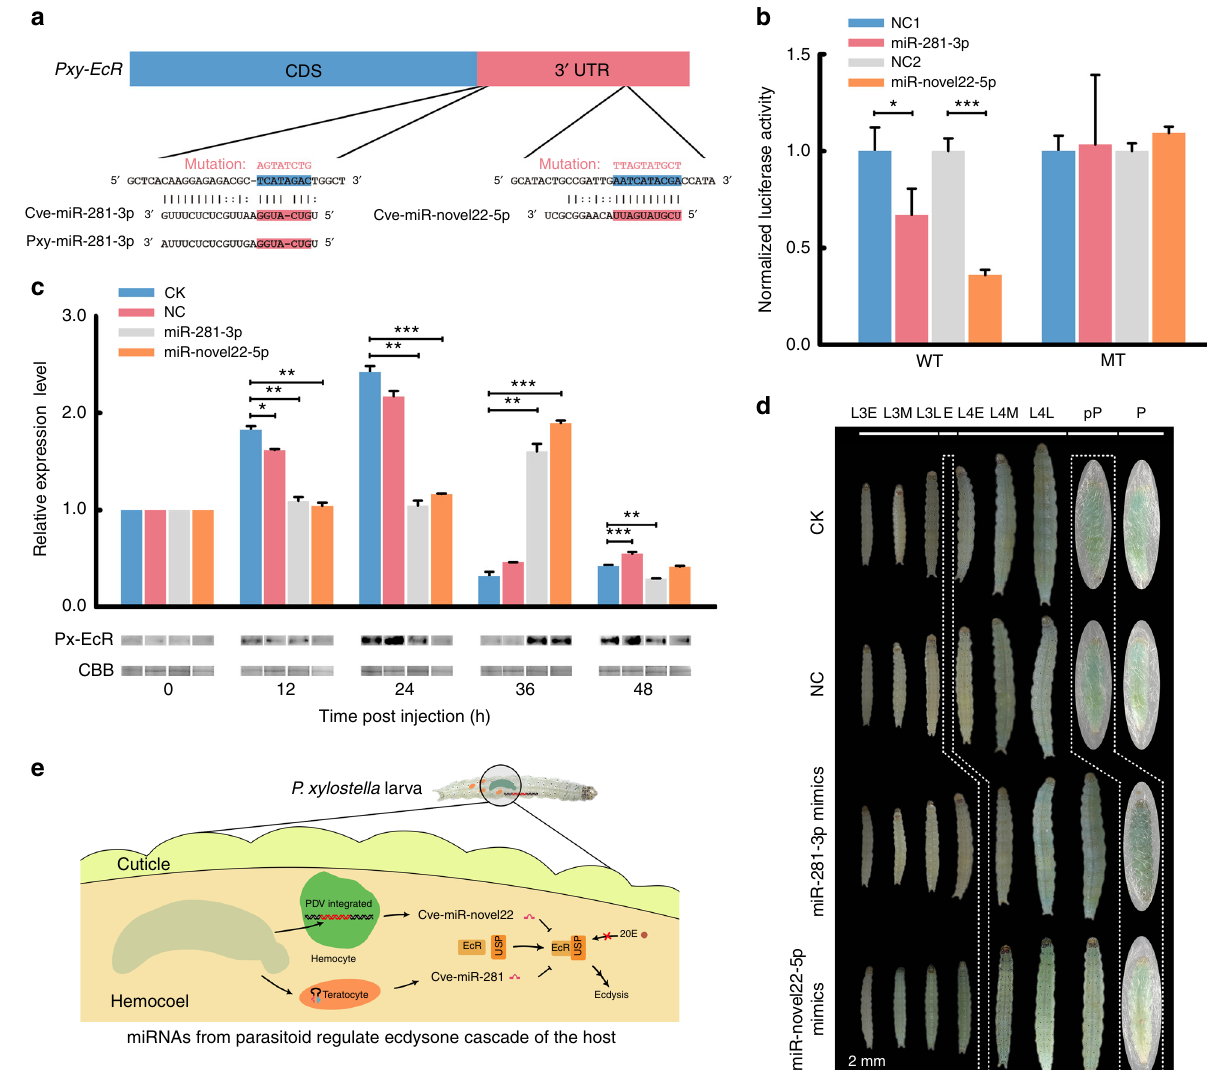
Fig. 4 Cve-miR-281-3p and Cve-novel22-5p delay growth and pupation of P. xylostella . a Nucleotide sequences showing the complementarity of Cve-miR- 281-3p/Cve-miR-novel22-5p and Pxy-miR-281-3p with the wild-type (WT) or mutant (MT) site (red letter) in Pxy-EcR on the Cve-miR-281-3p seed-binding region, highlighted in red. b EcR 3 ′ -UTRs are direct targets of Cve-miR-281-3p or Cve-novel22-5p. pMIR-REPOR- EcR luciferase constructs, containing a WT